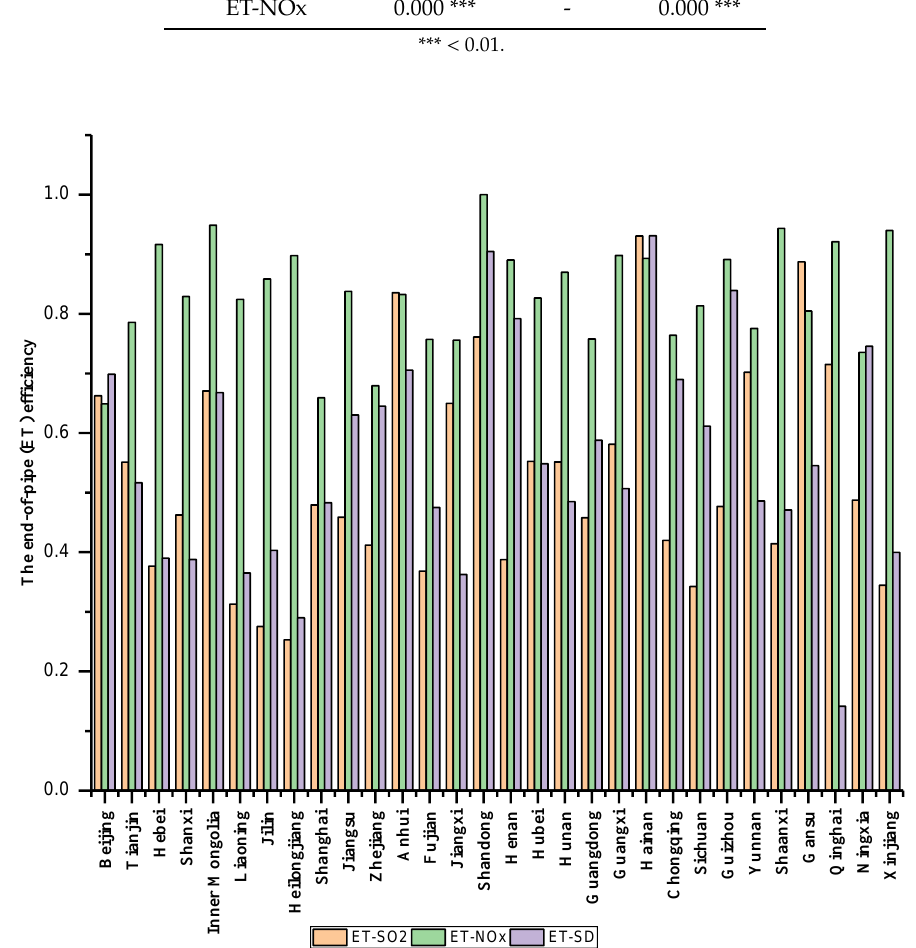
Figure 5. Average ET efficiency of SO 2 , NOx, and soot and dust.